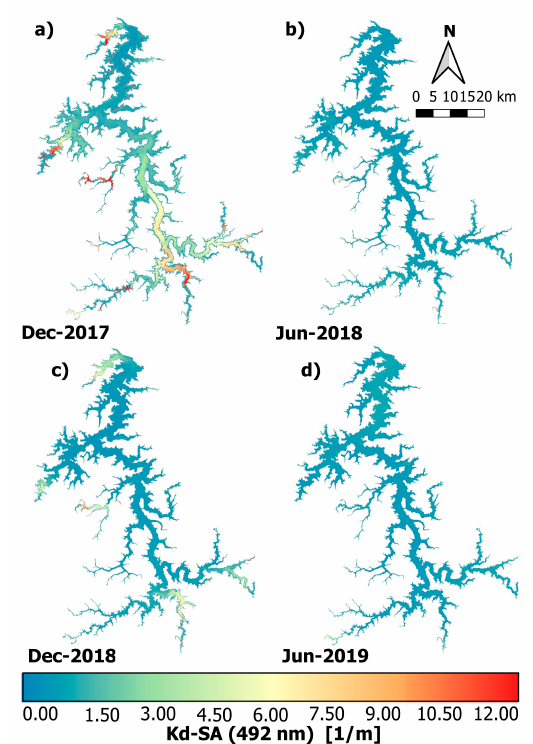
Figure 16. During the dry season (Figure 16b,d), the 𝐾 (cid:3031)(cid:2879)(cid:3020)(cid:3002) (492) is more spatially homogeneous, while for the rainy season (Figure 16a,c), higher gradients can be found, mostly at the entrance of the tributaries and in the upper portion of the reservoir.